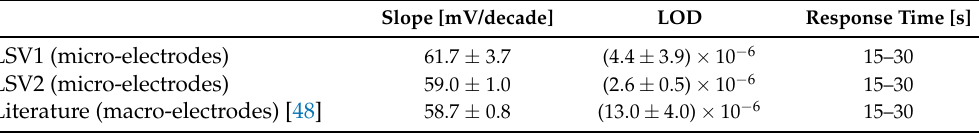
Figure 5. Calibration curve of lithium SC-ISE with platinum nanostructures deposited by LSV2. Table 2. Sensor parameters obtained from the calibration curves of the different fabricated Li + ISEs on micro-electrodes in comparison with the literature values on macro-electrodes. (Calibration range between 10 − 7 M and 10 − 1